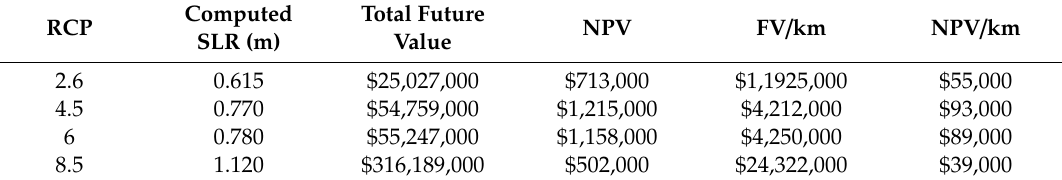
Table 8. Costs of coastal protection between 2020 and 2100 (2016 USD) (r = 7.5%; inflation = 1.7%).